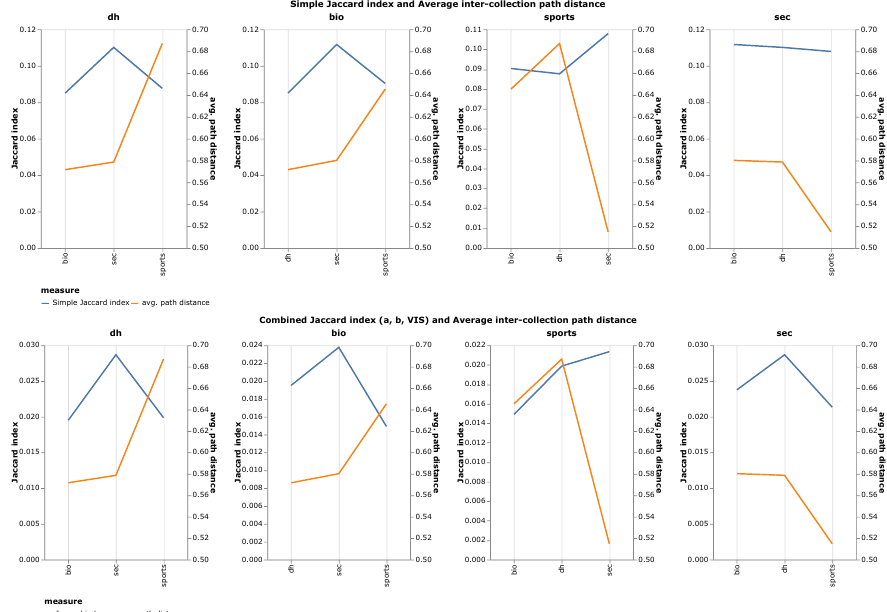
Figure 6. Diagrams showing possible interactions between intersection sizes between two collections ( top ) or two collections and the VIS collection ( bottom ) and average path distance between elements in those